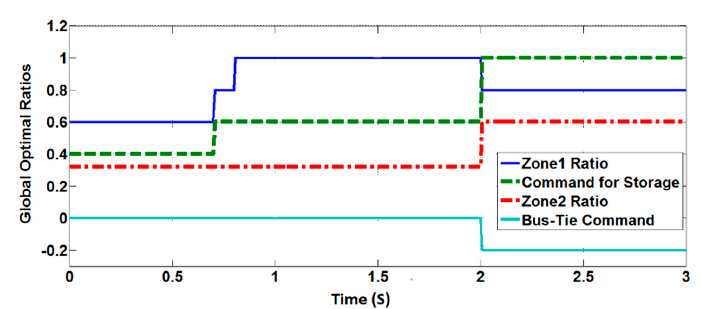
Figure 12. Converter operating points dictated by the agent-based controller.